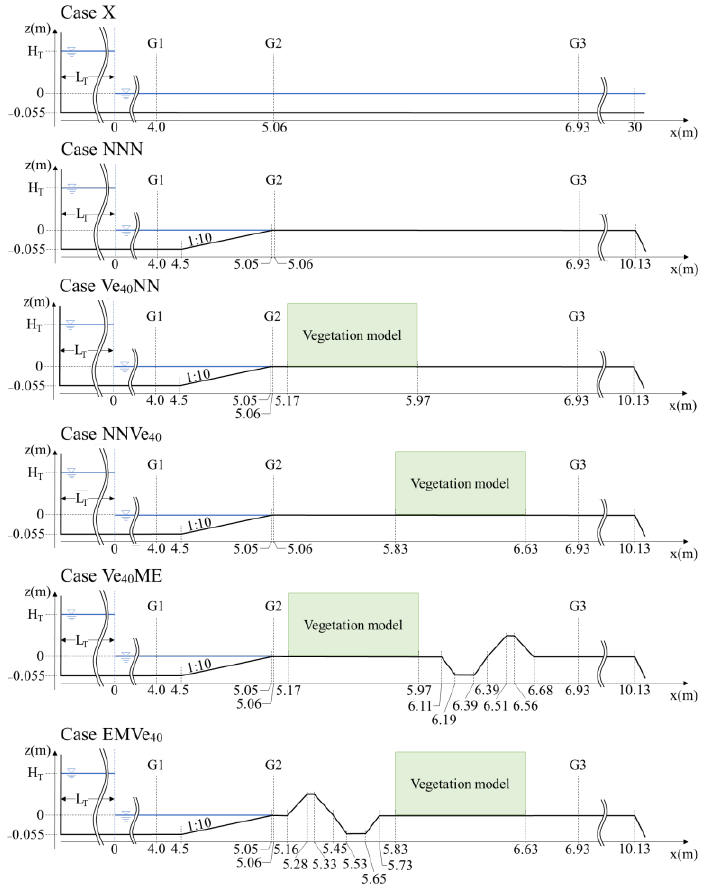
Figure 2. Schematic diagram of the experimental setups selected from Zaha et al. [10] for numerical model validation. Case name: N: no structure, Ve 40 : 40 rows of emergent vegetation (cylinders), E: embankment, M: moat.